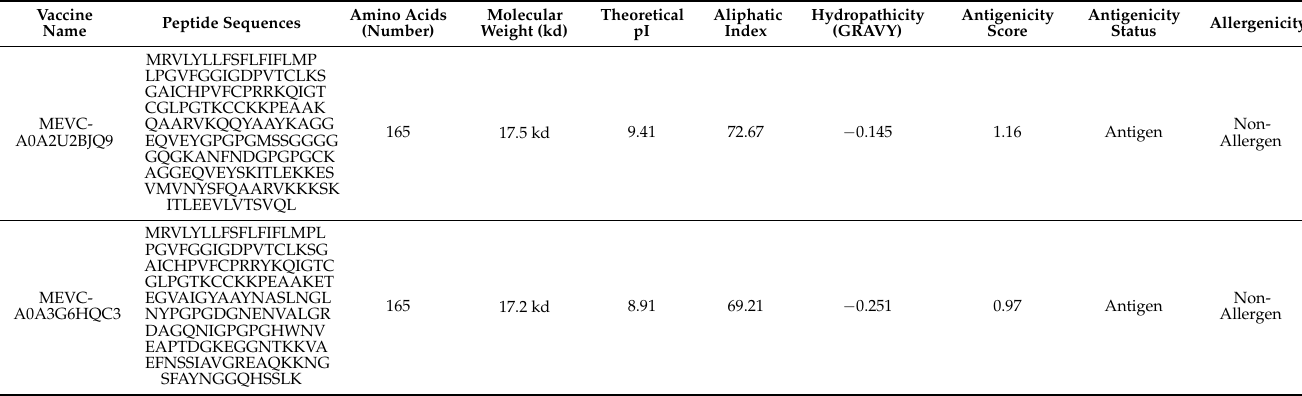
Table 3. The individually evaluated physiochemical properties, antigenicity, and allergenicity status of each target-specific peptide-based vaccine design against Alcaligenes faecalis